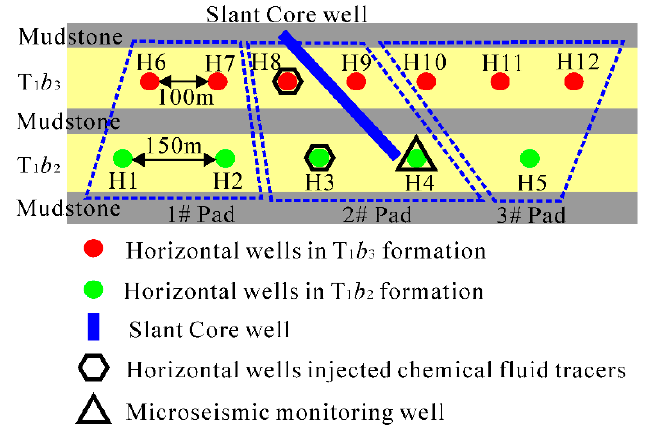
Figure 2. Elevation view of CHFTS wells, showing the relative position of the horizontal wells, test wells, and slant core well.